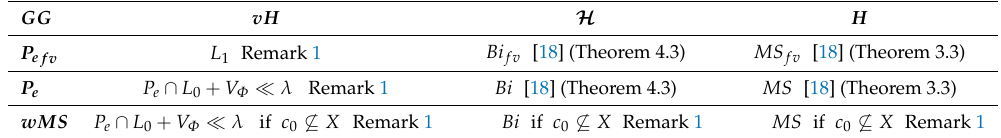
Table 1. Intersections. Arbitrary G